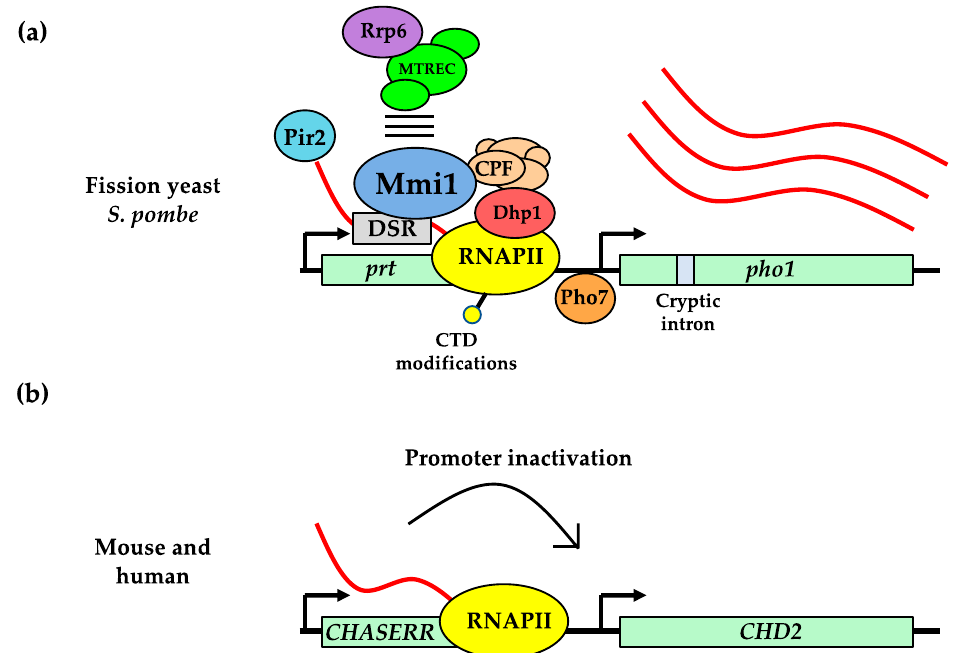
Figure 2. Gene expression control in cis by nearby lncRNAs. ( a ) In S. pombe , Mmi1 and additional protein factors, that are implicated in RNA processing and transcription regulation, associate with prt gene locus and lncRNA to affect expression of the downstream pho1 gene locus. ( b ) In mouse and human cells, the lncRNA CHASERR transcriptionally represses the downstream CHD2 gene through mechanisms that are currently unclear.